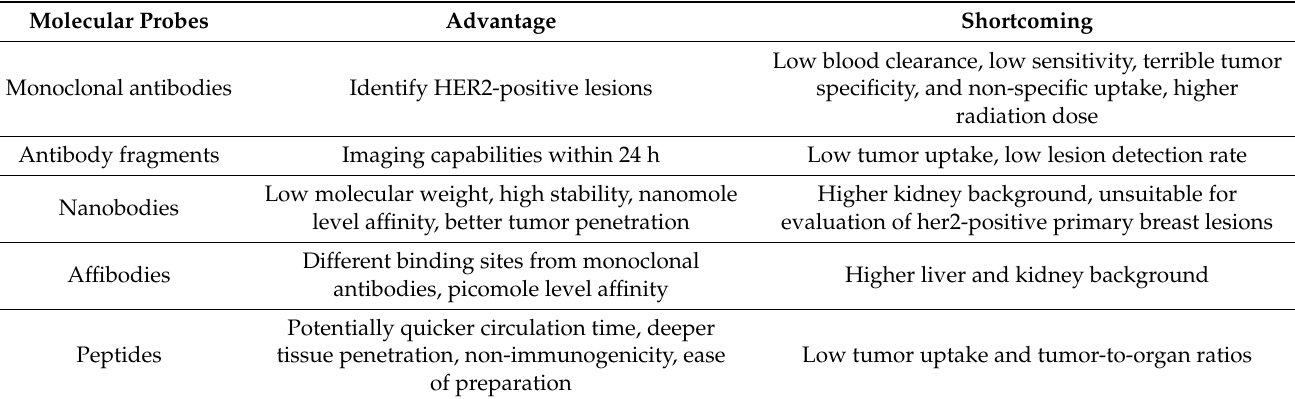
Table 6. The advantages and shortcomings of different types of molecular